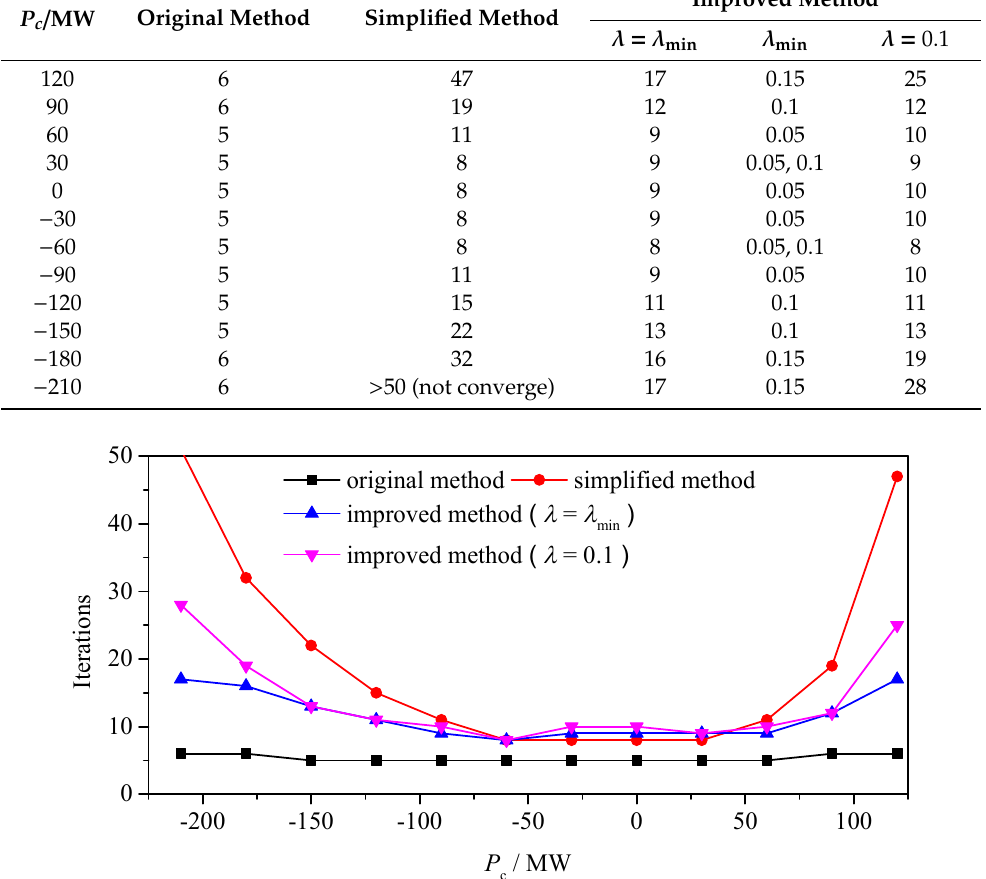
Table 3. Iteration numbers of the three methods under di ff erent P c .